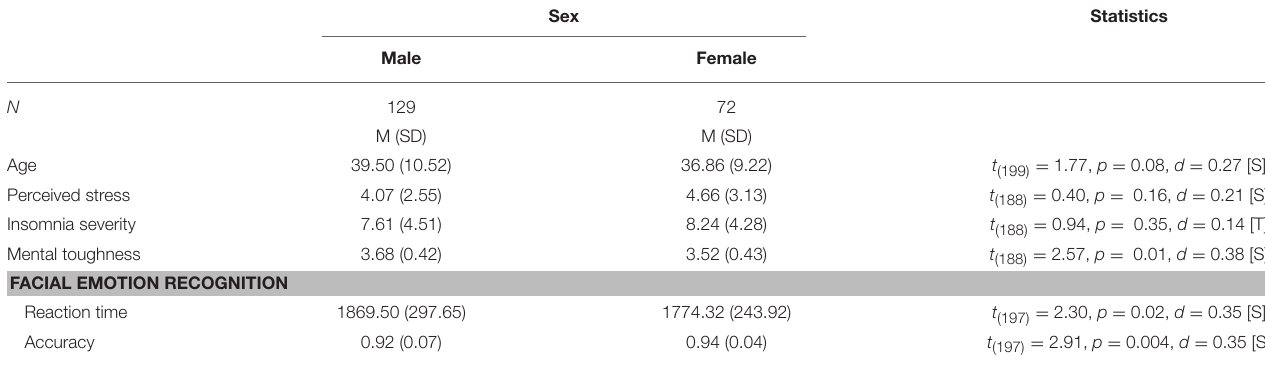
TABLE 2 | Descriptive and inferential statistical mean differences between male and female